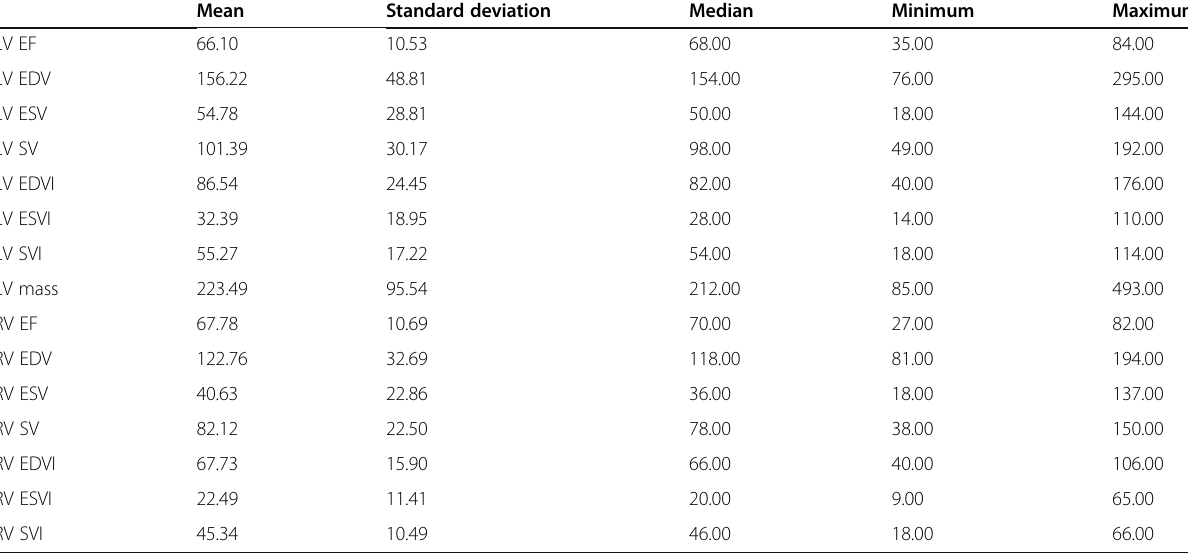
Table 1 Left and right ventricular volumes and functions among the study group Mean Standard deviation Median Minimum